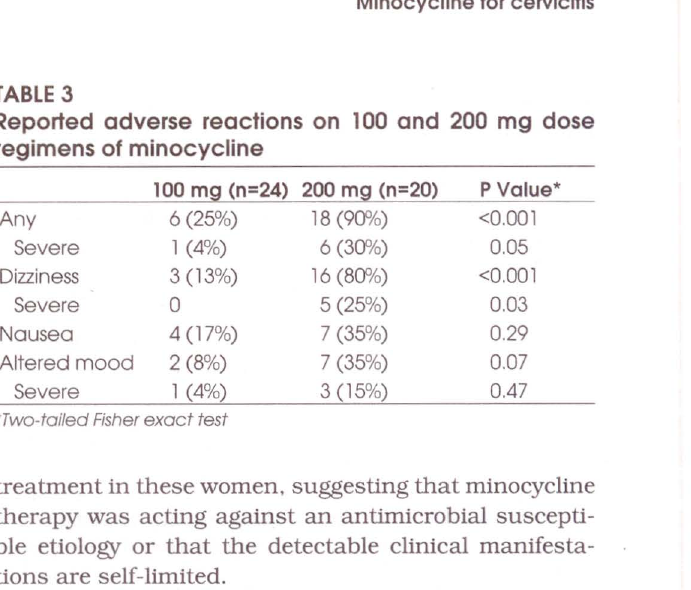
Reported adverse reactions on 1 00 and 200 mg dose regimens of